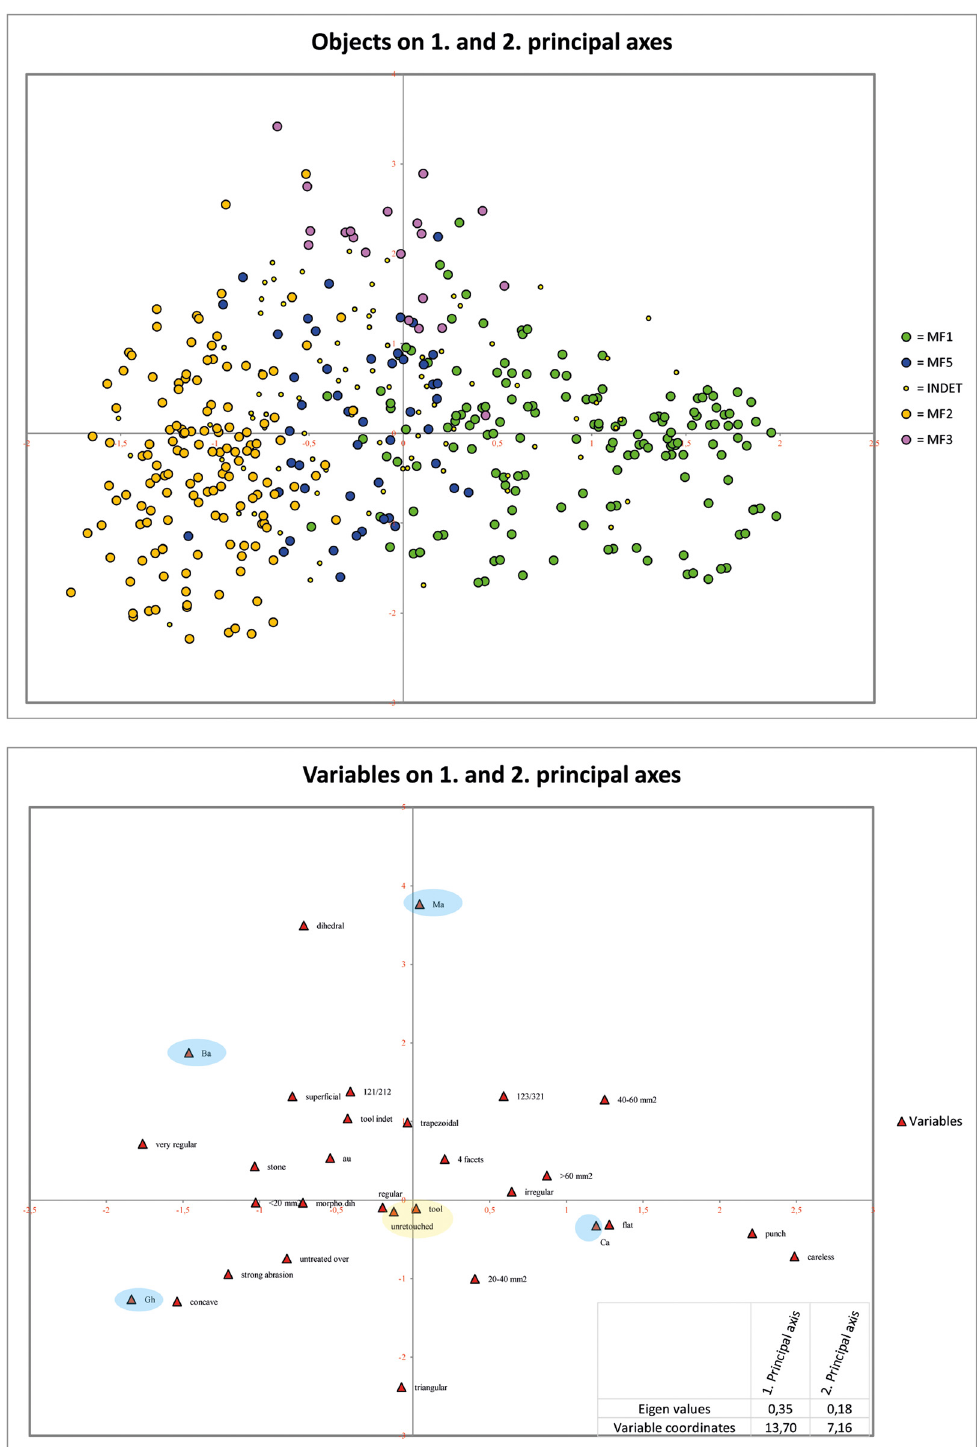
Figure 3: Correspondence analysis made on Blicquy data from Vaux - et - Borset settlement to verify whether the structure of empirically de fi ned MF1, MF2, MF3 and MF5 technological groups is relevant. See descriptive variables in the caption of Figure